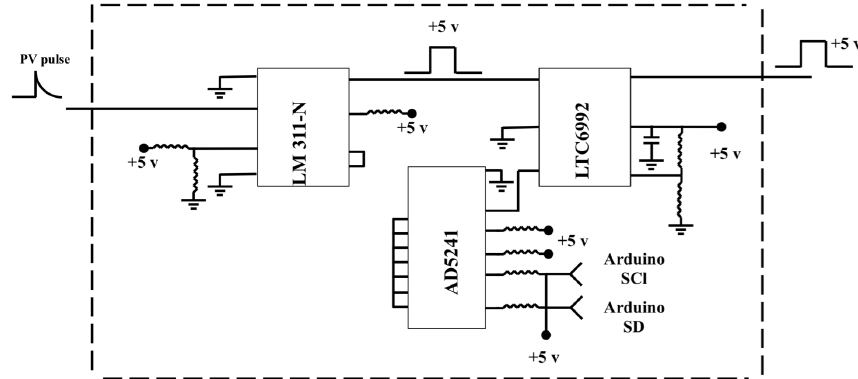
Figure 3. Schematic of the built-in delay generator.